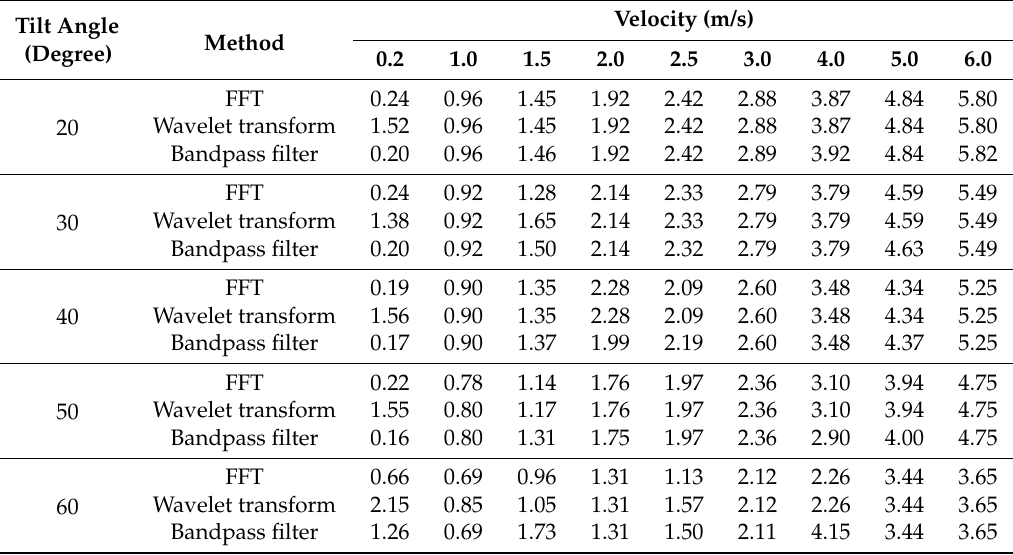
Table 1. Comparison of the identification results under different tilt angles and movement speeds of the trolley.